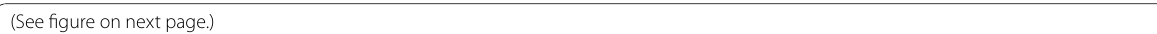
Fig. 4 Optimization of the initial cell concentration using the REMA. A suspension of the yeast strain AS03(pGAL1.1_hCAII) at varying final concentrations of 1 cells mL − 1 in 100 µL of SG to each well of a 96-well plate with varying concentrations of AZA (0, 6.25, 12.5 and 25 µM). The plates were incubated at 30 °C for 24 h whereupon resazurin was added and 4 h later the OD 572 and OD 600 values were measured and expressed as a the OD 572 /OD 600 ratio and b visual observation. Data are shown as a the